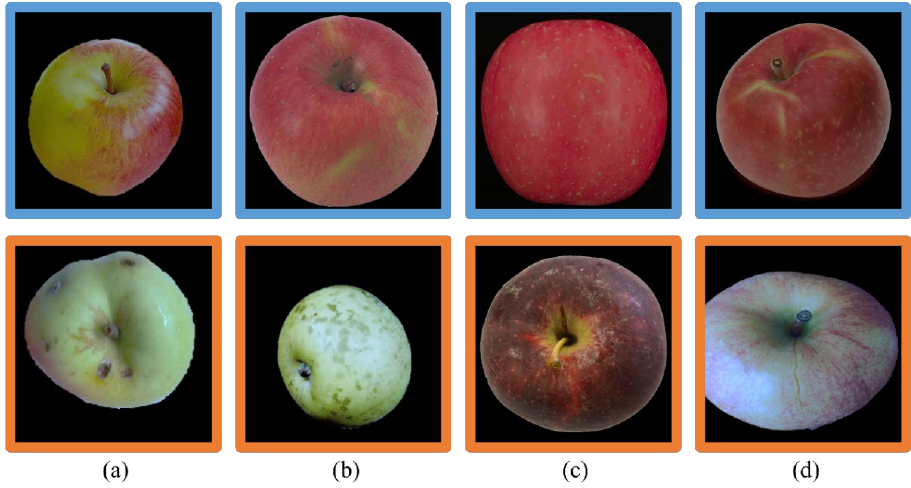
Figure 2. Non-defective apple images with a blue border, and defective apple images with an orange border. Among them, ( a , b ) defects are rot and plant disease caused by biological factors, respectively, ( c ) is a laceration caused by environmental factors, and ( d ) is mechanical damage caused during packing and transportation.